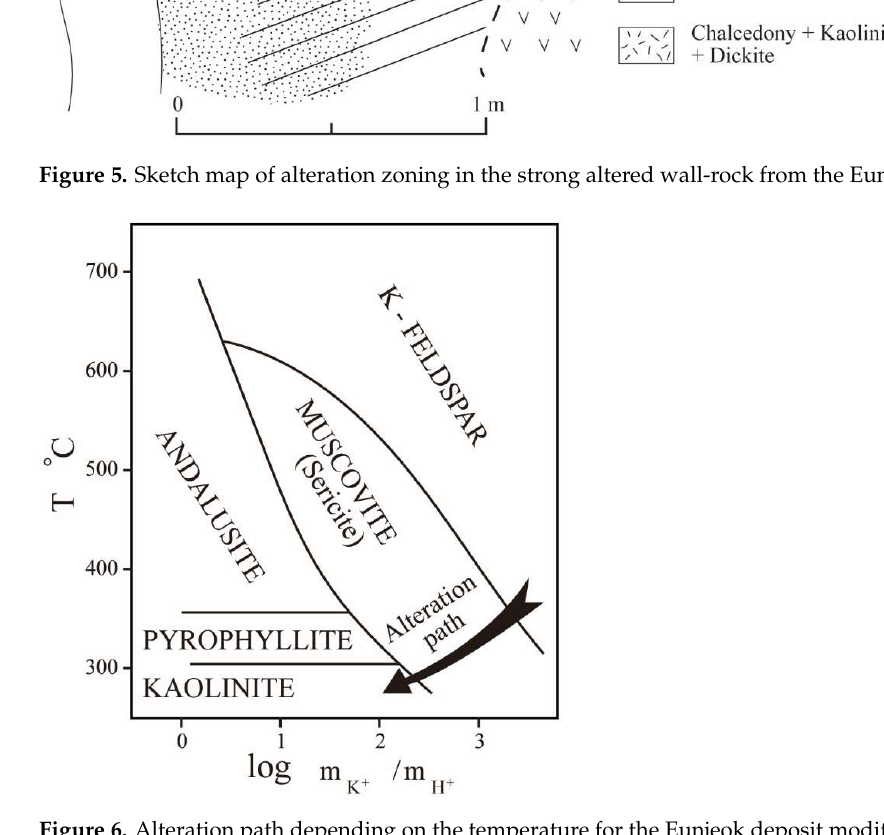
Figure 6. Alteration path depending on the temperature for the Eunjeok deposit modified from [18]. Table 2. K–Ar data of alteration sericite, Eunjeok Au–Ag deposit. Sericite from a vein alteration halo in the Eunjeok deposit was measured to be a K– Ar date of 86 ± 7.7 Ma, indicating a Late Cretaceous age for Au–Ag mineralization (Table 2).